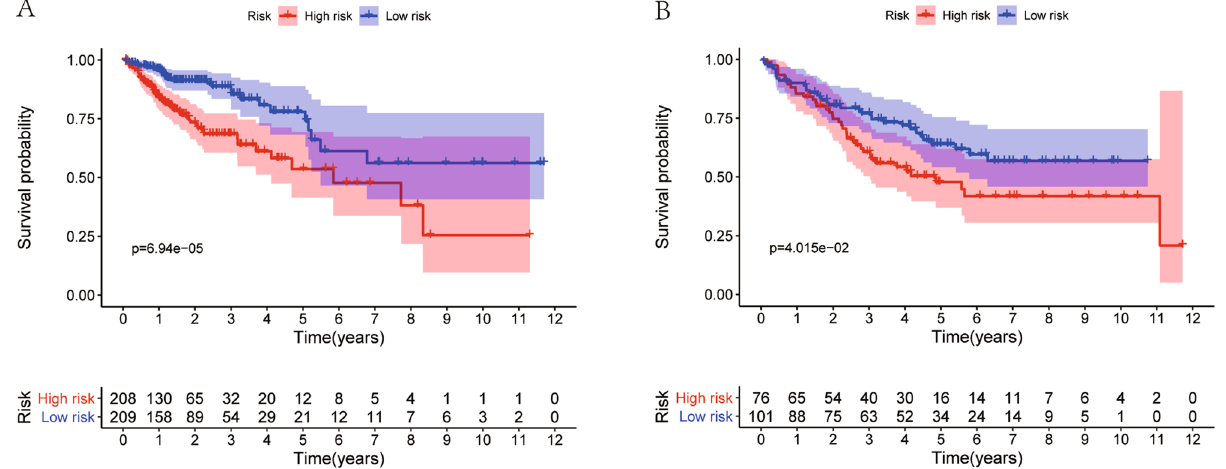
Figure 3. Kaplan–Meier curves of Metabolic Signature. ( A ) Kaplan–Meier curves of gene signature based on TCGA. ( B ) Kaplan–Meier curves of gene signature based on GEO.